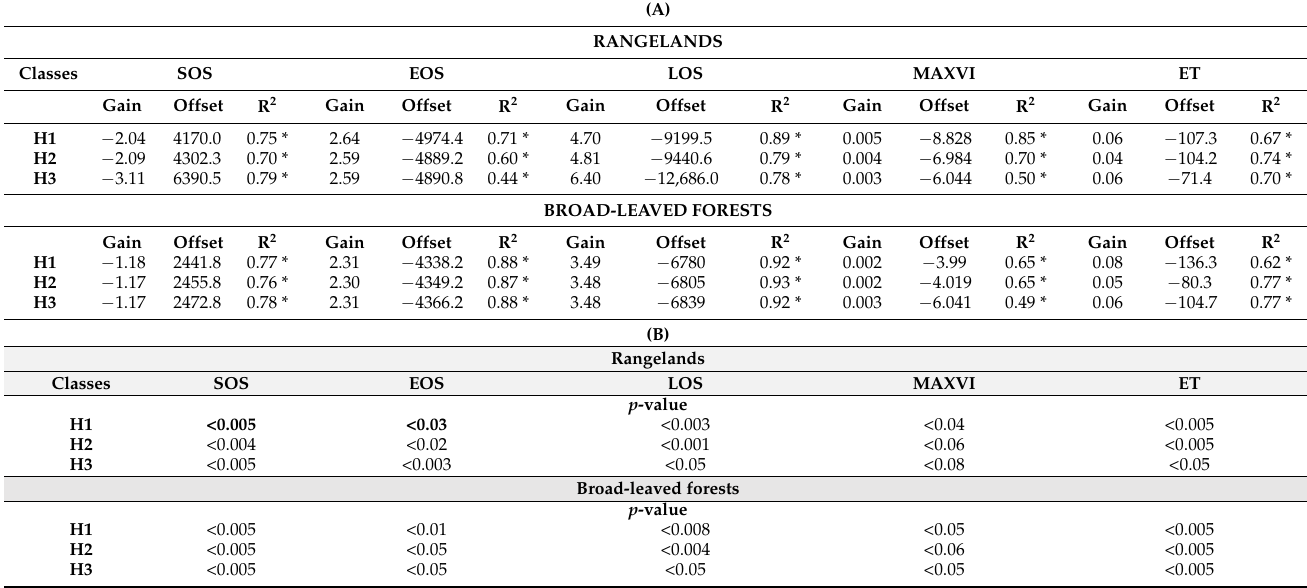
Table 4. ( A ) 1st order polynomial coefficients and corresponding coefficients of determination (R 2 ) of calibrated models relating PMs with years (2000–2019) for the considered height classes. ( B ) p -values of trends computed for analyzed height classes and parameters. SOS: start of season; EOS: end of season; LOS: length of season; MAXVI: maximum vegetation index; ET: